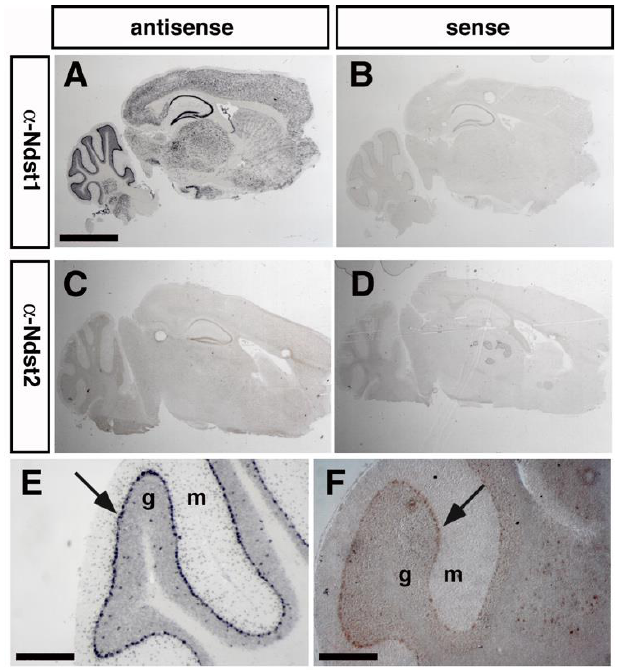
Figure 5. Widespread expression of Ndst1 in the adult brain, and partially overlapping Ndst2 expression in cerebellar Purkinje cells, cortex and hypothalamus. ( A ) Ndst1 mRNA is widely expressed in various brain areas, notably the hippocampus and the cerebellum. Scale bar: 2 mm. ( B ) sense control mRNA demonstrates specificity. ( C ) Ndst2 expression throughout the adult brain. ( D ) sense control mRNA. ( E ) In situ hybridization analysis demonstrates strong Ndst1 expression in cerebellar Purkinje cells, and weak but overlapping expression of the Ndst2 isoform ( F ). Scale bar: 200 µ m. m: molecular layer, g: granule cell layer.